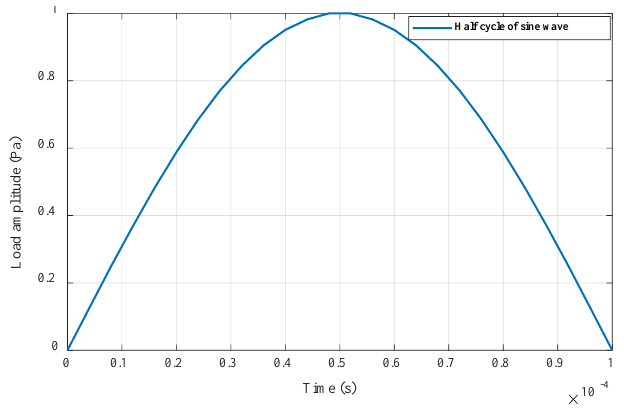
Figure 3. A half sine wave acoustic impulse.